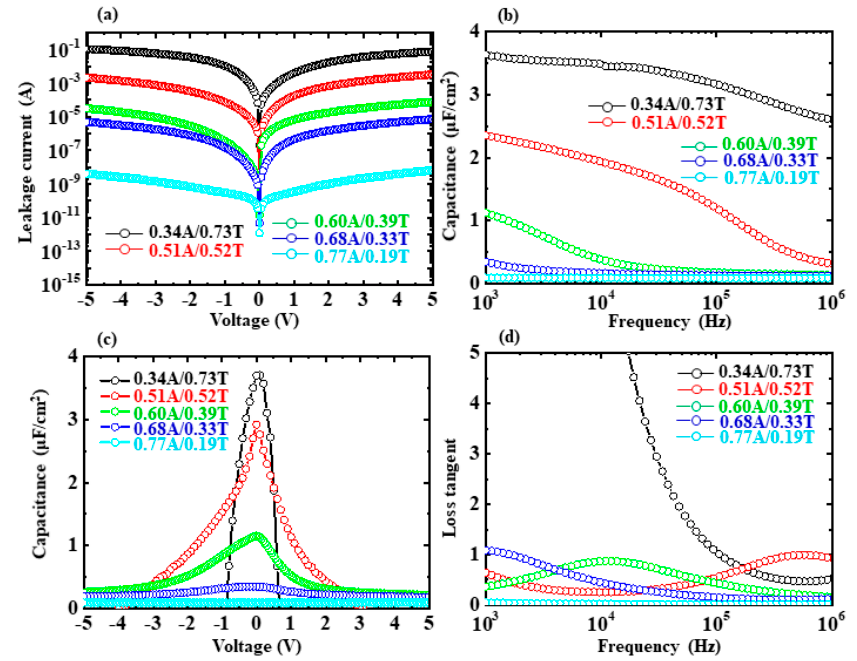
Figure 6. ( a – d ) Leakage current-voltage, capacitance-frequency, capacitance-voltage, and loss tangent-frequency characteristics for the Si/Ti/Pt/ATO NL/Ti/Au capacitors with the variation in AlO x and TiO y contents. The deposition temperature, total NL thickness, and each ATO sublayer thickness were kept at 200 °C, around 100 nm, and around 1 nm, respectively. The ATO sublayer thicknesses change from 0.34A/0.73T to 0.77A/0.19T.